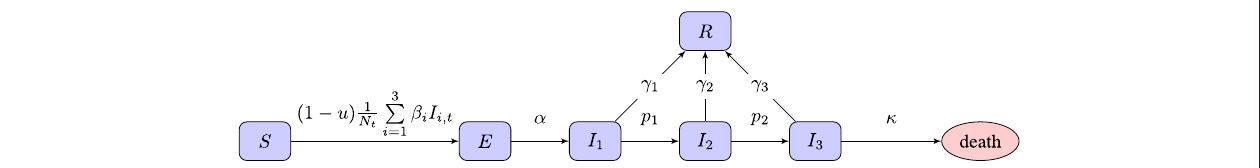
FIGURE1| FlowchartoftheSEI 3 Rmodelweemploy.Amember ofthesusceptiblepopulation S movestoexposed E afterbeingexposedtoaninfectiousperson, where “ exposure ” is de fi ned as the previous susceptible person contracting the illness. After some incubation period, a random duration parameterized by α , they develop amildinfection( I 1 ).Theymaytheneitherrecover,movingto R ,orprogresstoasevereinfection( I 2 ).From I 2 ,theyagainmayrecover,orelseprogressfurthertoa critical infection ( I 3 ). From I 3 , the critically infected person will either recover or